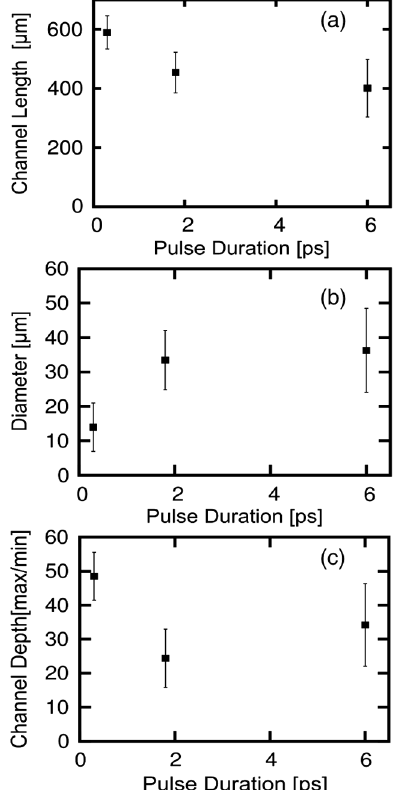
FIG. 12. Plasma channel parameters at different pulse durations (0.3, 1.8, and 6 ps). (a) Channel length, (b) channel diameter, (c) channel depth (maximal density/minimal density).